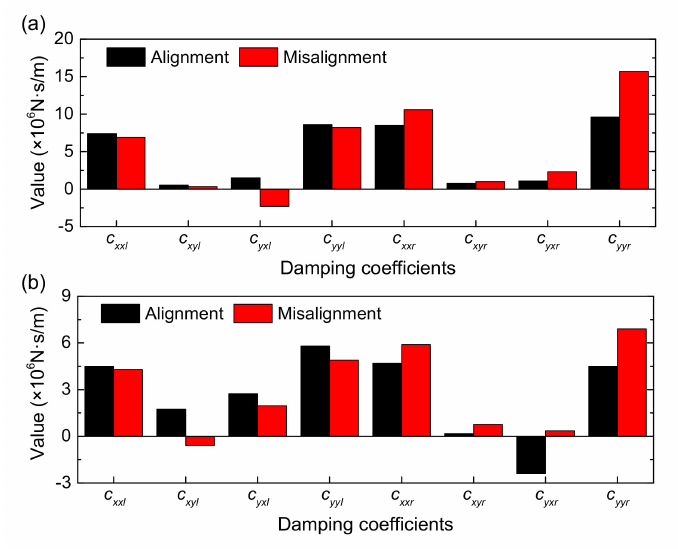
Figure 14. Bearing damping coefficients with shaft state at two rotational speeds: ( a ) 50 r/min; ( b ) 225